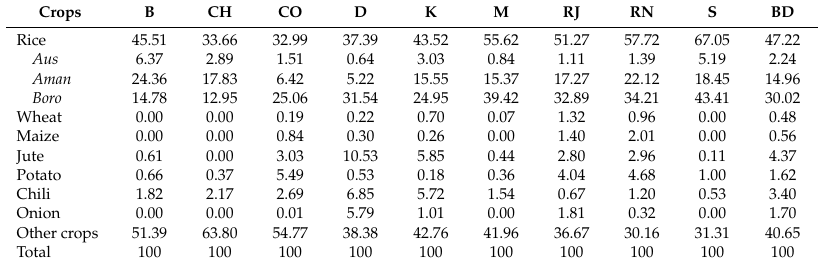
Table A2. Each agricultural crop’s share in total net agricultural income (%), by region. Crops